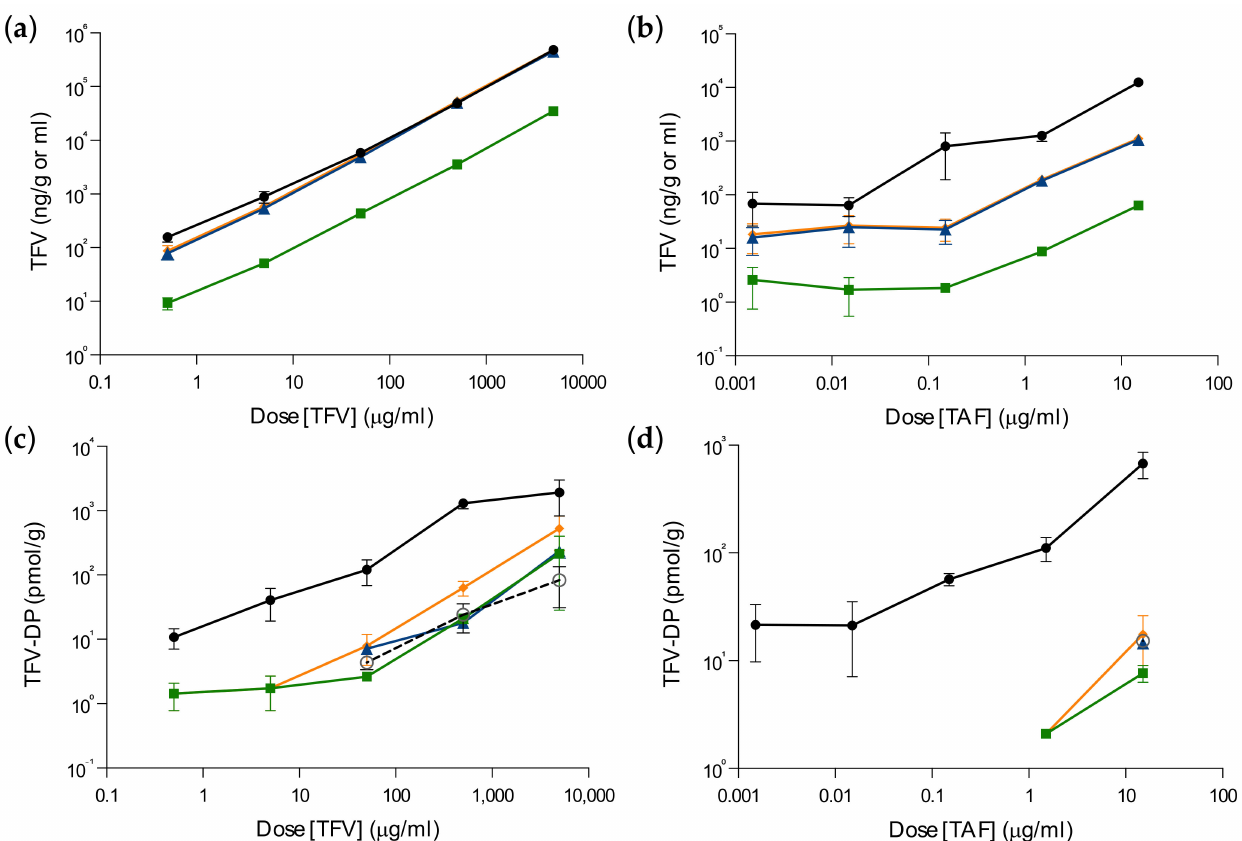
Figure 3. Tenofovir and tenofovir–DP loss following ex vivo dosing of foreskin explants. Tissue explants were dosed with TFV ( a , c ) or TAF ( b , d ) for 3 h, washed in PBS and then cultured in the absence of drug. TFV ( a , b ) and TFV–DP ( c , d ) levels were measured in the dosing supernatant after 3 h of culture ( ), in pooled washed buffer ( (cid:4) ), in culture supernatant ( (cid:78) ) and in tissue explants ( • ) (cid:35) harvested after 48 h of culture. Total analyte levels post-dosing (during washing and culture) were calculated ( (cid:7) ). Data are the means (SEMs) from independent experiments performed in triplicate with specimens from three